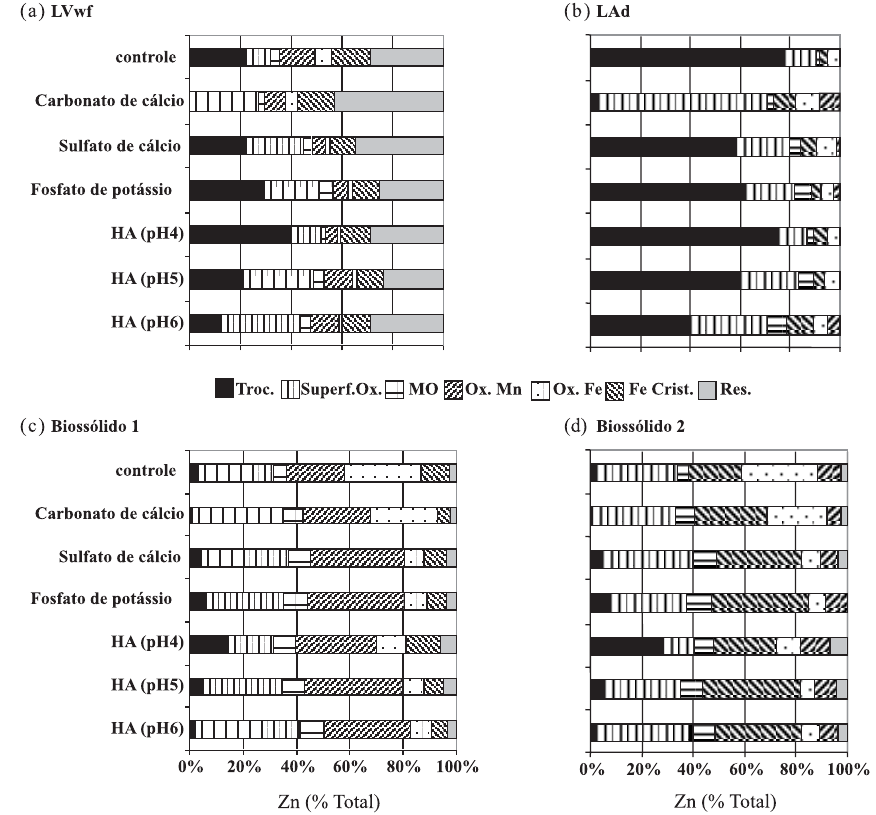
Figura 4 Distribuição das formas de zinco nas amostras de solo e biossólido após os equilíbrios nas câmaras duplas de difusão. LVwf: Latossolo Vermelho acriférrico; LAd: Latossolo Amarelo distrófico; Biossólido 1: biossólido equilibrado com LVwf; Biossólido 2: biossólido equilibrado com LAd; Troc.: trocável; Superf. Ox.: superfície de óxidos; MO: matéria orgânica; Ox. Mn: óxidos de Mn; Ox. Fe: óxidos de Fe mal cristalizados; Fe Crist.: óxidos de Fe cristalinos; Res.: